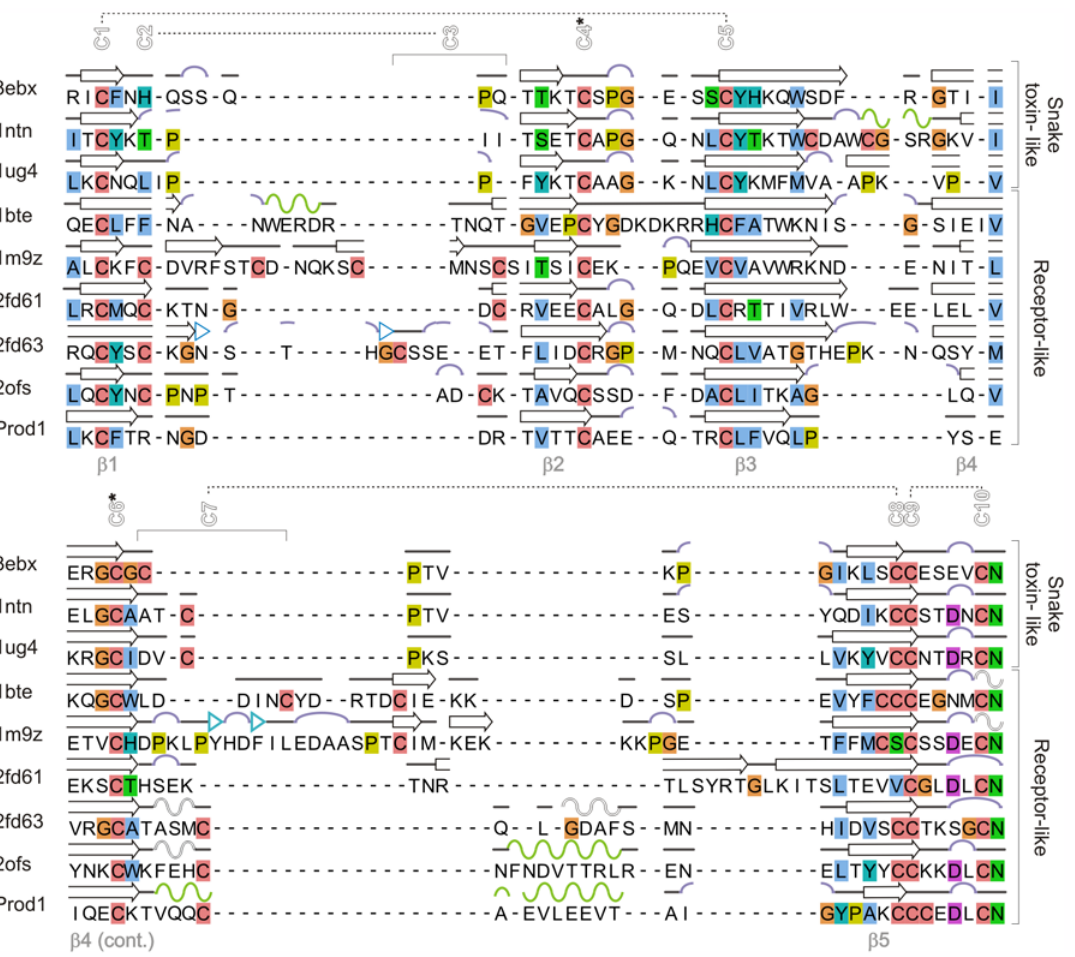
Figure 2. Structure-based multiple sequence alignment of selected TFP 3D structures highlighting the regular secondary structure features. Alpha-helices are shown in green, 3 10 - helices in white, b -strands in black, bends in purple and b -bridges in cyan. The canonical cysteines are numbered at the top and disulfide-bond connectivities are indicated by the dotted lines or by stars. Glycines are colored in orange, prolines in yellow and cysteines in pink; other positions are colored according to conservation of chemical properties: hydrophobic in blue, aromatic in cyan, polar negative in purple, polar positive in red, and polar neutral in green.